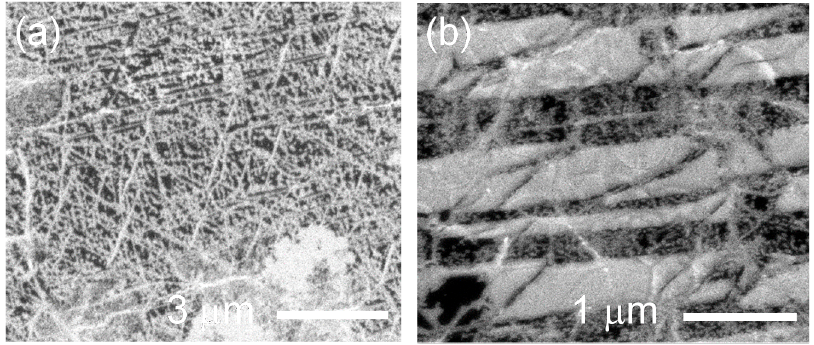
Figure 7. ( a , b ) Various growth modes can be identified for 5-nm alumina on graphene when still on 25 micron thick Cu a 25 micron thick Cu foil.